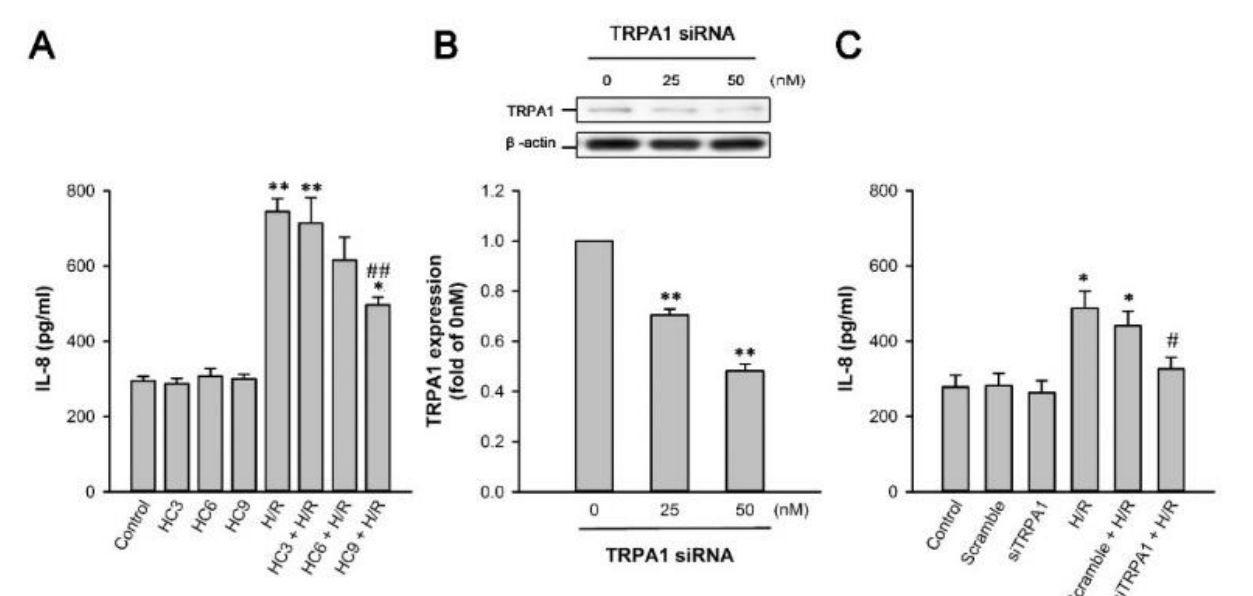
Figure 6. TRPA1 mediated the induction of IL-8 by H/R in HK-2 cells. ( A ) HK-2 cells were incubated under normoxia conditions as control or exposed to 2.5% O 2 for 6 h, followed by 4 h of reoxygenation. In 6 study groups, cells were pretreated with 3, 6, or 9 µ M HC-030031 (HC3, HC6 or HC 9; a TRPA1 antagonist). ( B ) HK-2 cells were incubated under normoxia conditions with or without the application of TRPA1 siRNA (siTRPA1) at two concentrations (25 and 50 nM) 48 h prior to the measurement of TRPA1 expression. Protein expression was analyzed by Western blot. ( C ) HK-2 cells were incubated under normoxia conditions as control or exposed to 2.5% O 2 for 6 h, followed by 4 h of reoxygenation. In the 4 study groups, cells were pretreated with 50 nM of siTRPA1 or scramble siRNA. Protein expression was analyzed by ELISA. Data in each group are mean ± SEM from 6 independent experiments. * p < 0.05 versus the control group; ** p < 0.01 versus the control group; # p < 0.05 versus the H/R group without pretreatment of siRNA; ## p < 0.01 versus the H/R group without pretreatment of